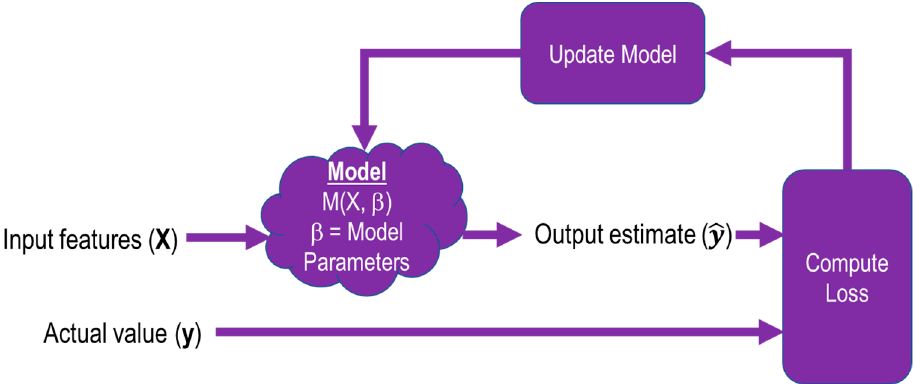
Figure 2. Training Process.